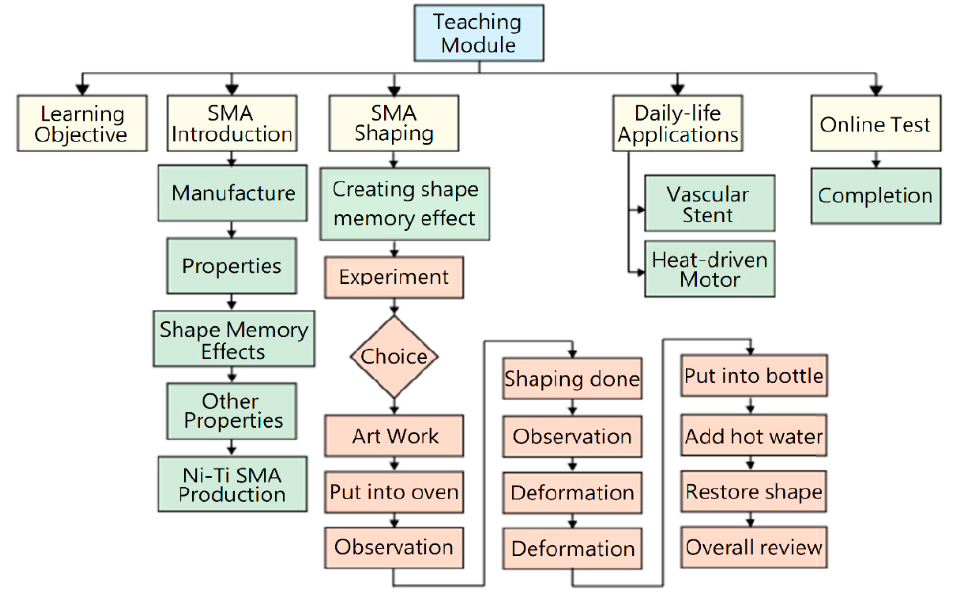
Figure 9. Operating flowchart of the SMA teaching module.